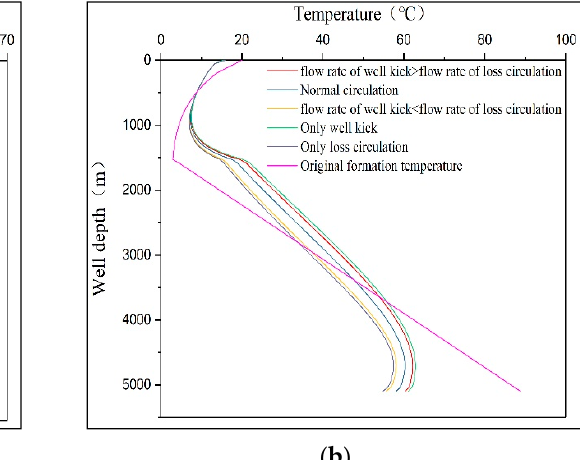
Figure 7. Annulus temperature during different circulation time under multi-pressure system. ( a ) The multi-pressure system is located in the middle open formation; ( b ) The multi-pressure system is located at bottom hole.